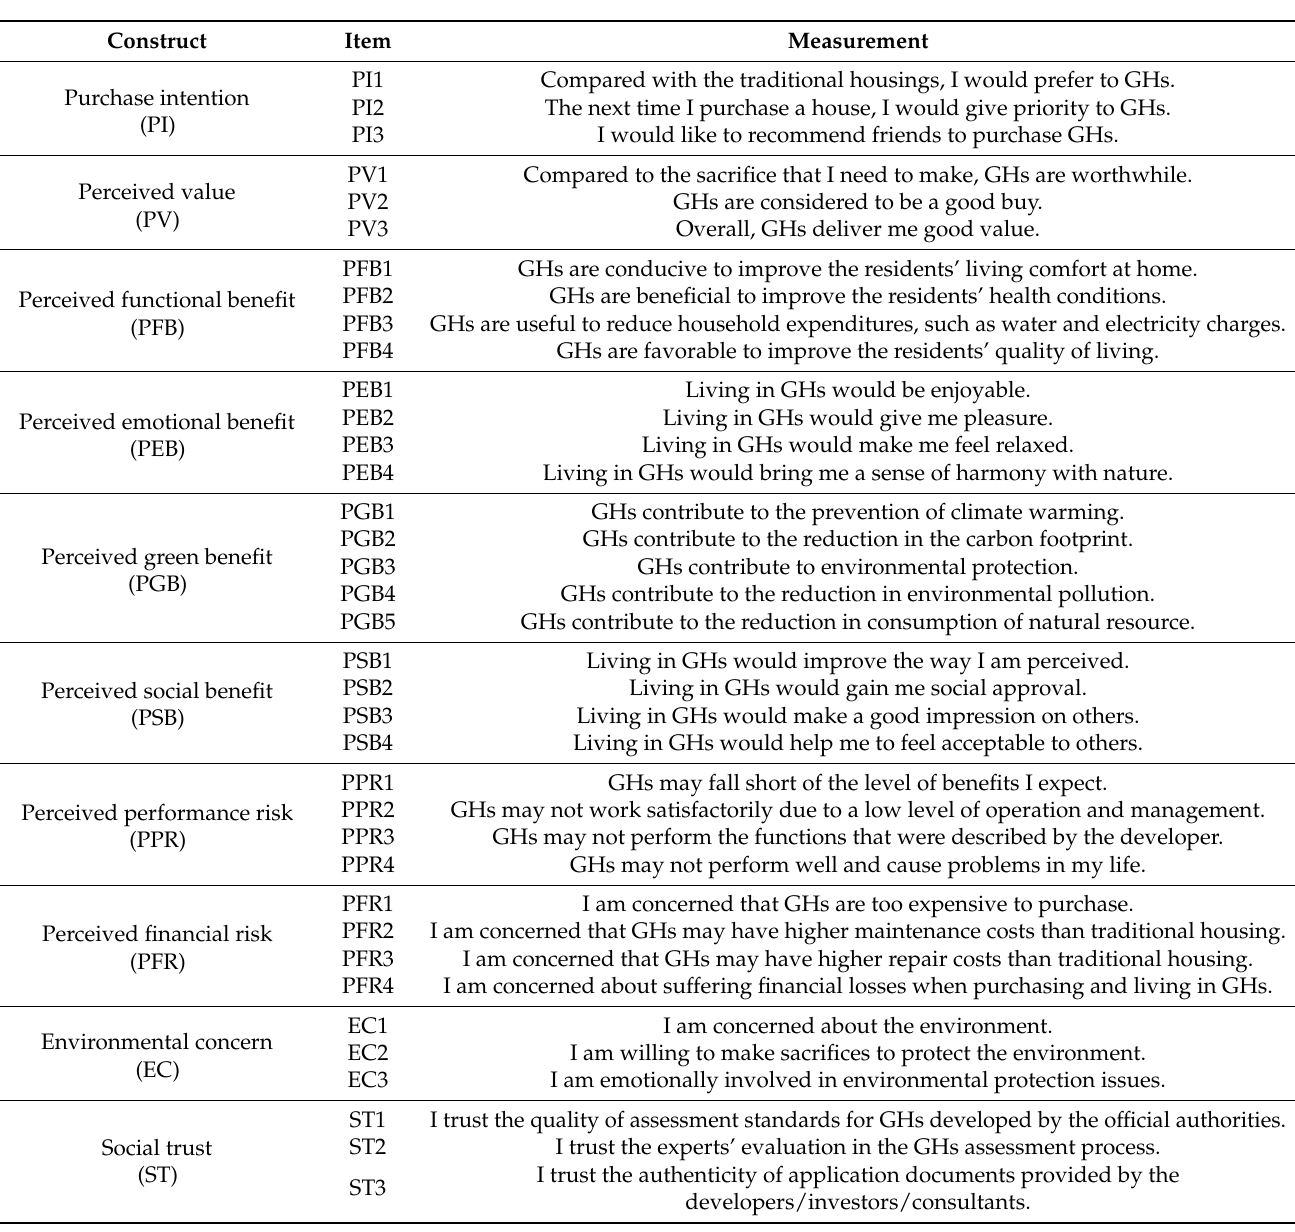
Table 1. Measurement